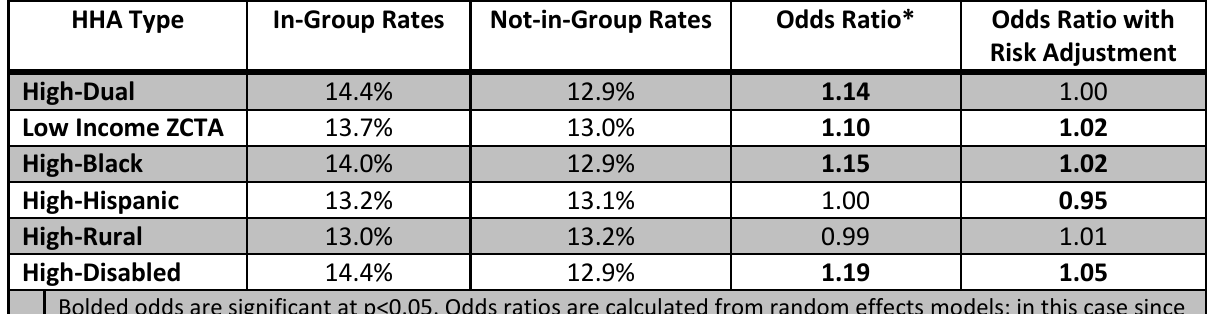
Table 13.7: HHAs Serving a High Proportion of Socially At-Risk Beneficiaries, Re-Hospitalizations FYs 2012-2014